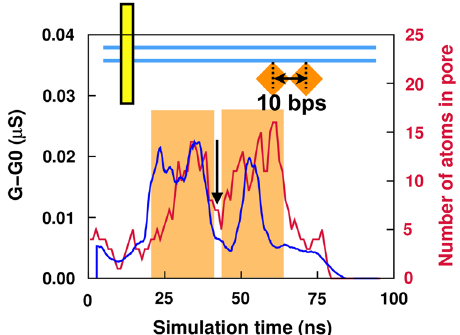
Fig. 6 Higher resolution of methylation detection using transverse electronic current in MoS 2 . The differential conductance is shown together with the number of protein/DNA atoms occupying the pore as a mDNA-MBD1 complex containing two methylation sites separated by 10 bps is translocated through a MoS 2 nanopore (same as Fig. 5c). The arrow marks a dip between two peaks, each corresponding to the permeation of a MBD1 protein bound to a methylation DNA methylation with 2D material nanopores. Further results show that multiple methylation sites are distinguishable in a